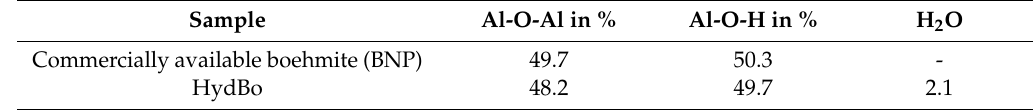
FigureA2. ComparisonofO1’speakofcommercialboehmiteNPs(left)andhydrothermallysynthesized Figure A2. Comparison of O 1 ’ s peak of commercial boehmite NPs (left) and hydrothermally boehmite layer on epoxy substrate (right). synthesized boehmite layer on epoxy substrate (right). Table A1. Comparison of the percentage ratios of the fitted O 1’s Figure A2. Comparison of O 1 ’ s peak of commercial boehmite NPs (left) and hydrothermally synthesized boehmite layer on epoxy substrate (right).